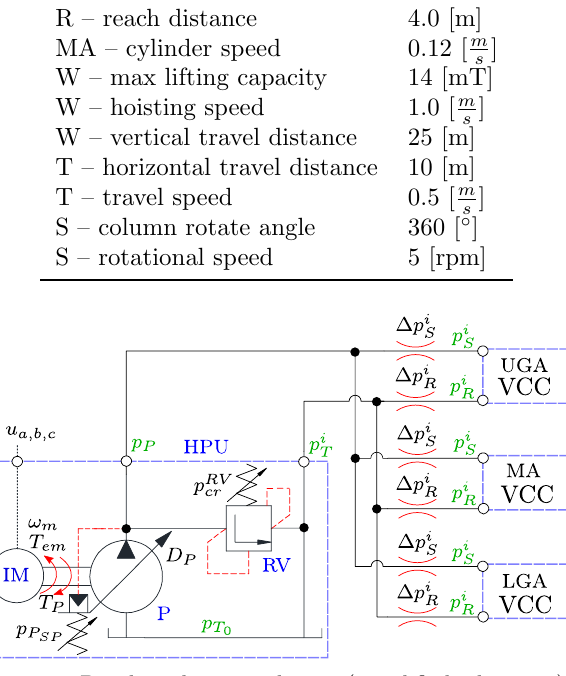
Figure 8: Benchmark system layout (simplified schematic).